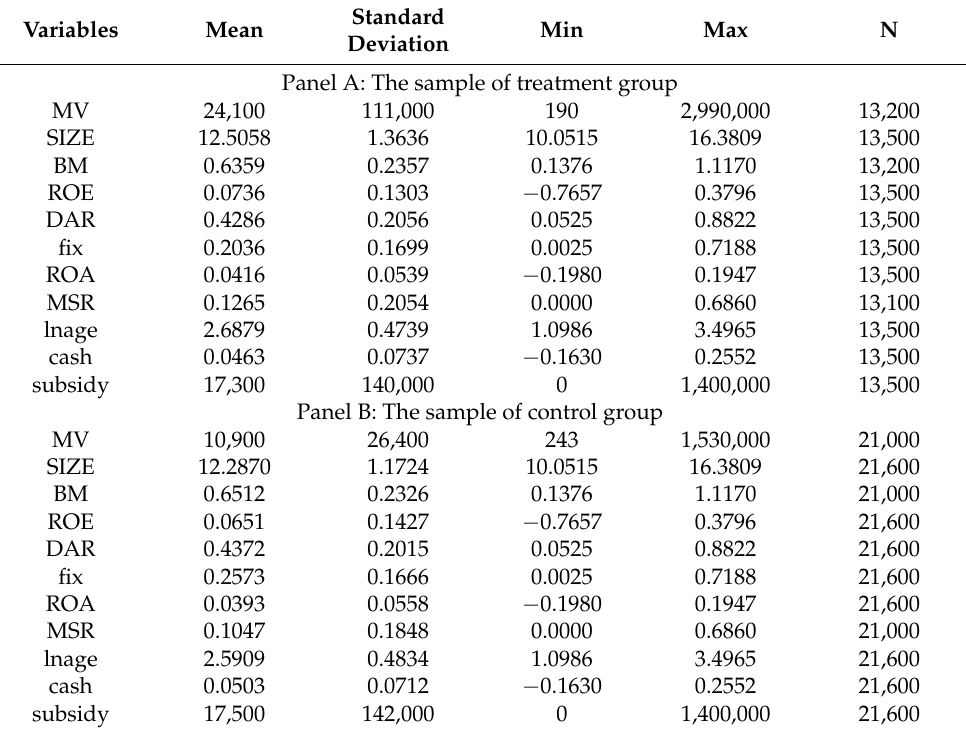
Table 3. Summary descriptive statistics of the main